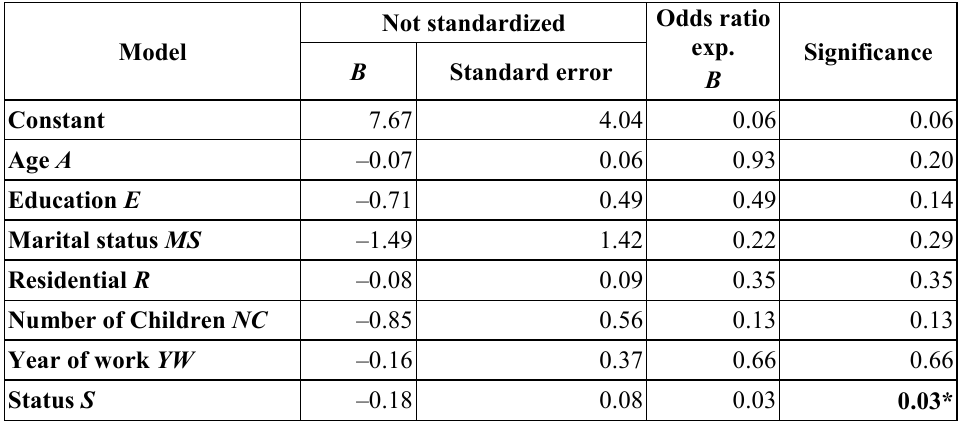
Table 3. Logistics Regression Analysis for Reporting